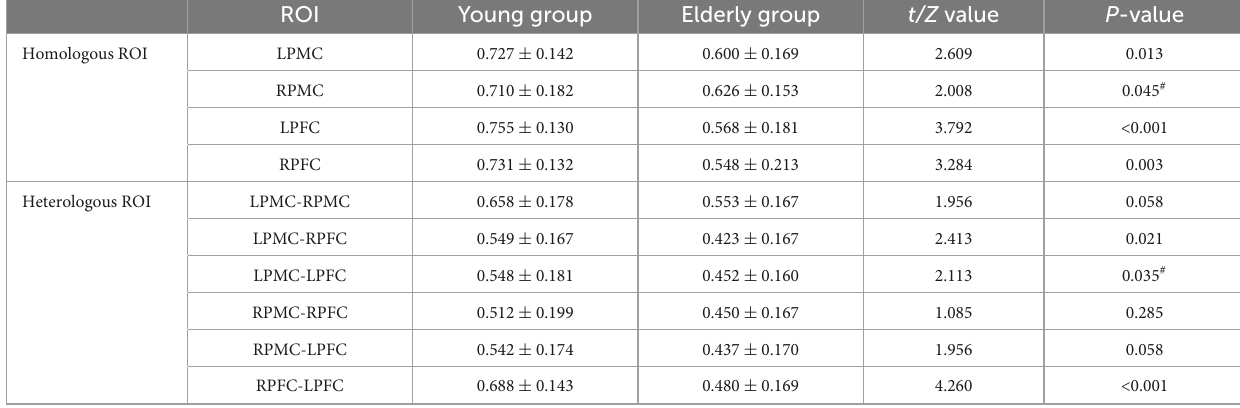
TABLE 4 Comparison of functional connectivity (FC) values of homologous and heterologous brain networks between the two groups in reverse judgment test. ROI Young group Elderly group t/Z value P -value Homologous ROI